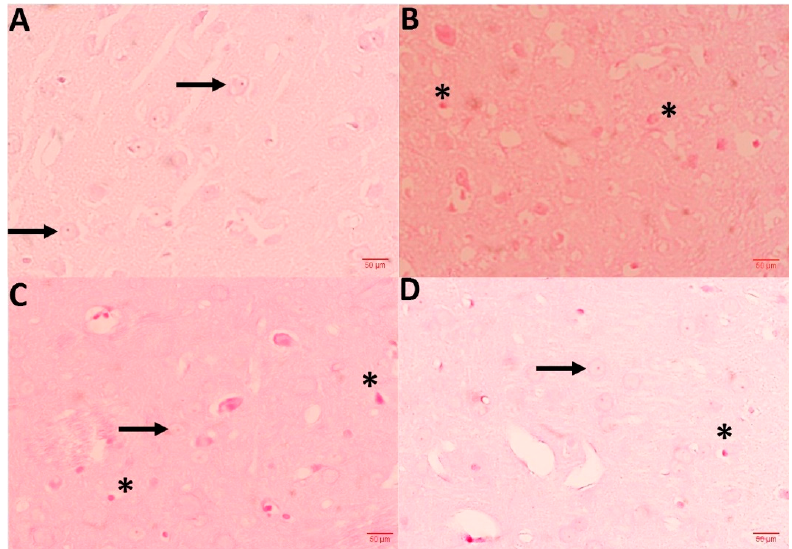
To access the CPM-induced neurodegenerative alteration, 5 μ m thick brain tissue sections were obtained from all groups and stained in H&E. Sections from the control group represent the normal architecture and morphology of neuronal cells, while the CPM group exhibits markable changes, such as vacuole development, the presence of pyc- notic nuclei, and infiltrating cells. Sections from CPM group treated with NC displayed gaining normal architecture of neuronal cells. NC alone did not represent any morpho- logical alteration when compared with the control group (data not shown) (Figure 7).